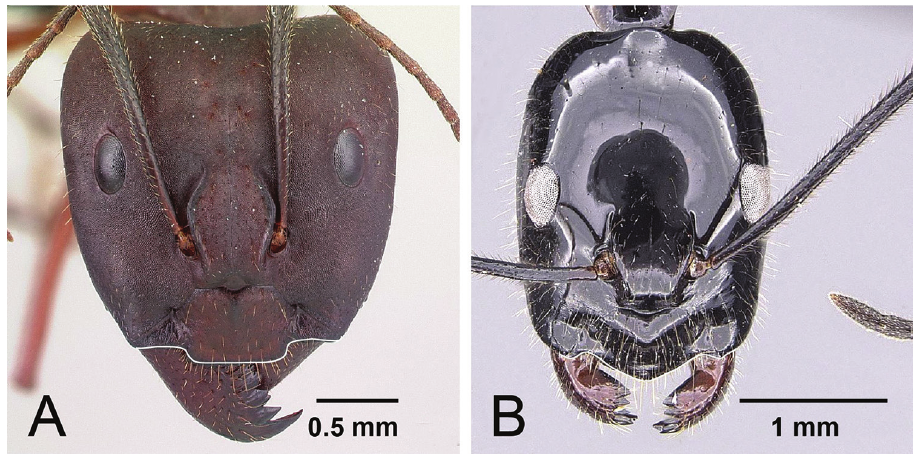
Figure 5. Head of major worker in full-face view. A Camponotus imitator (CASENT0452863), head wedge-shaped B Camponotus karaha (CASENT0151921), head